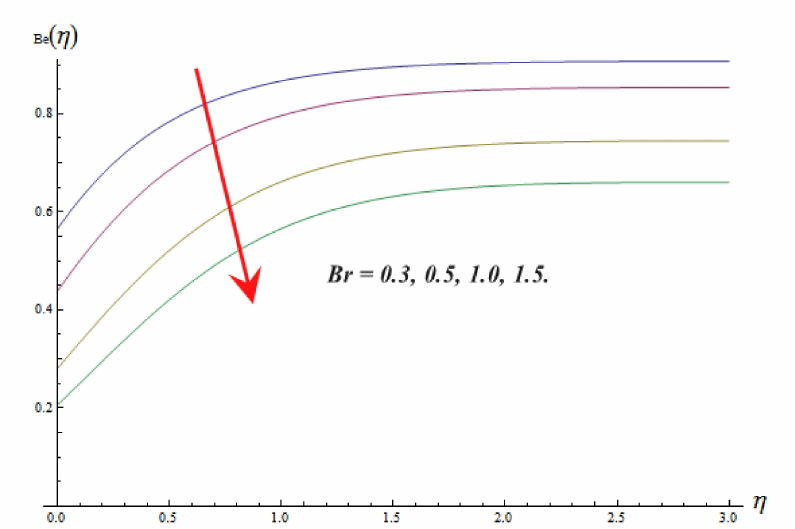
Figure 15. Impact of Br on Be ( η ) keeping Pr = 0.5, Ha = 0.2, Γ = 0.2, λ = 2, Ec = 0.2, Rd = 2, β 1 = 0.2, λ 1 = 0.2, K ∗ = 2.